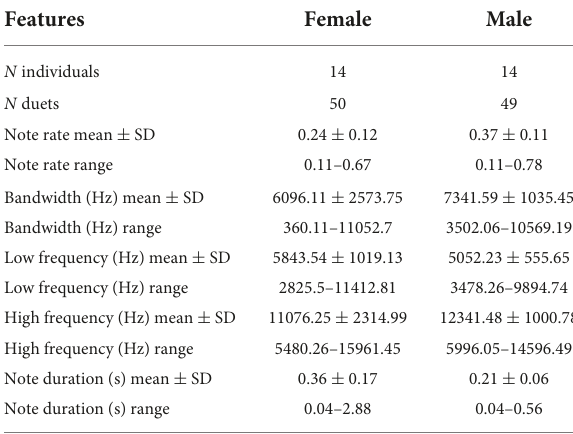
forest algorithm using the “pam” function in the “cluster” R package (Maechler et al., 2012). K-medoids is more robust version of K-means (Madhulatha, 2011). K-medoids requires the input of the number of clusters (k) so we ran the algorithm iteratively for values of k from 2 to 10 and then calculated a silhouette coefficient for each cluster